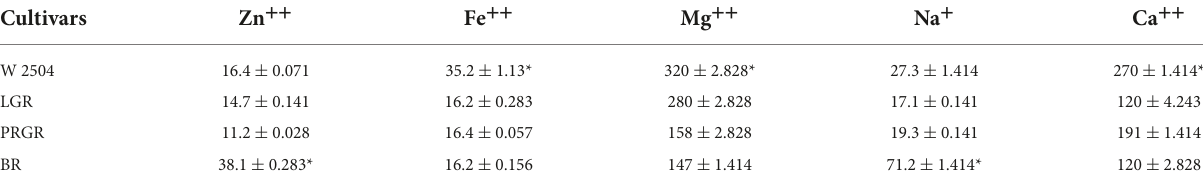
TABLE 3 Microelement content of different rice and common